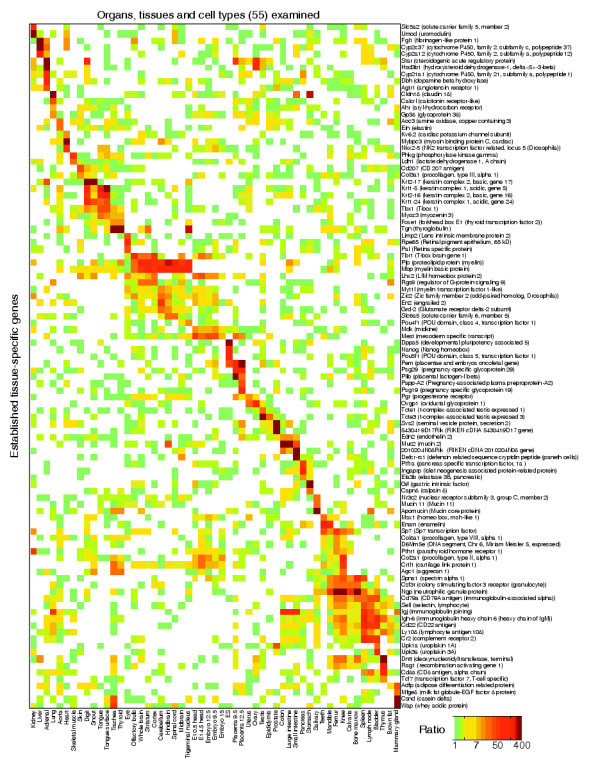
Expression of previously characterized tissue-specific genes. Genes were identified manually by searching MEDLINE abstracts [66] and XM sequence description fields (see Additional data file 1) for keywords corresponding to the appropriate tissues. Rows and columns were ordered manually.